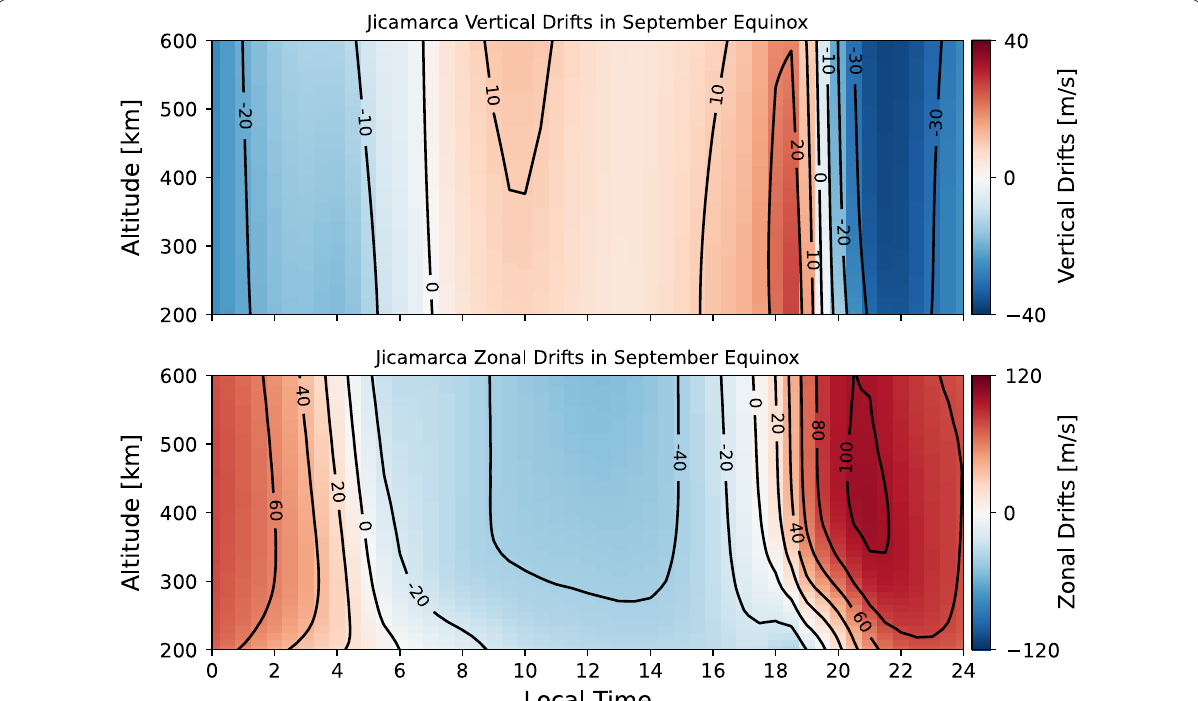
Fig. 5 Vertical (top) and zonal (bottom) plasma drifts at Jicamarca for equinox high solar flux